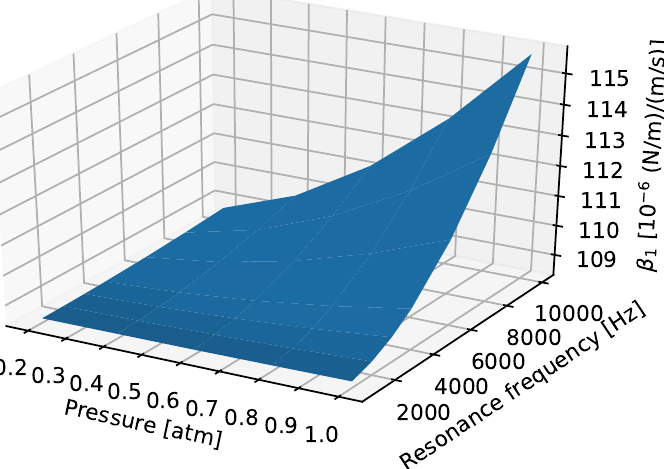
Figure 8. β 1 as the function of resonance frequency and environmental